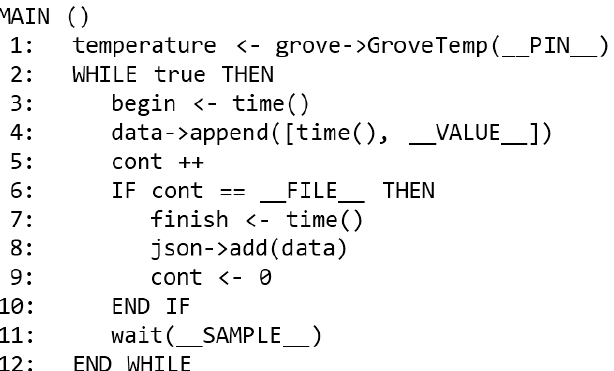
Figure 5. Pseudocode Script Example from the Encoder.